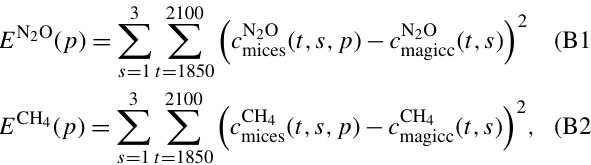
RCPs (Meinshausen et al., 2011), as well as emulating the global mean temperature response of